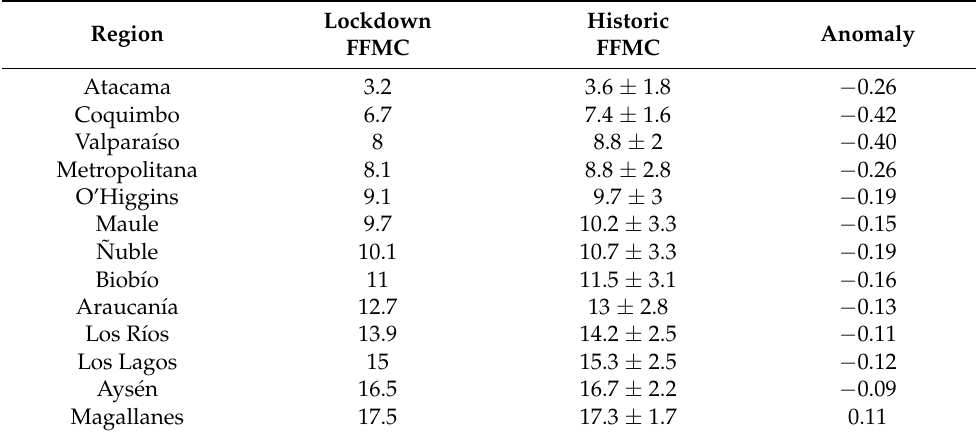
Table 2. FFMC anomaly (%) for the current season. Estimated historical values within the range 2001–2020 (20